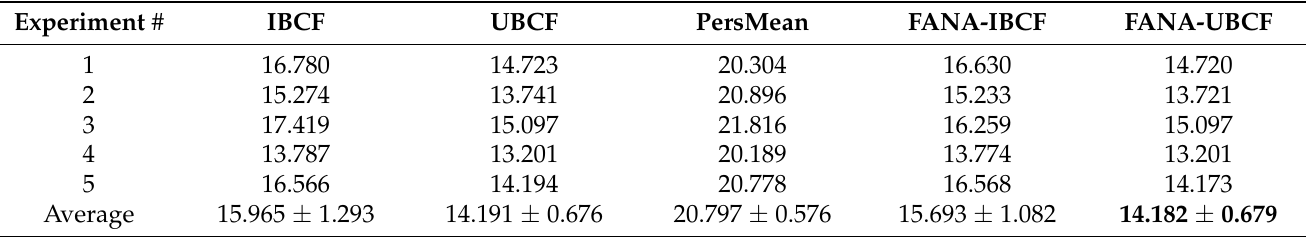
Table 3. Comparison of mean absolute error (MAE) performance among item-based collaborative filtering (IBCF), user- based collaborative filtering (UBCF), personalized mean (PersMean), and our proposed approach, FANA-CF, using 5-fold cross validation. We have calculated the average of MAE value and the standard deviation for each